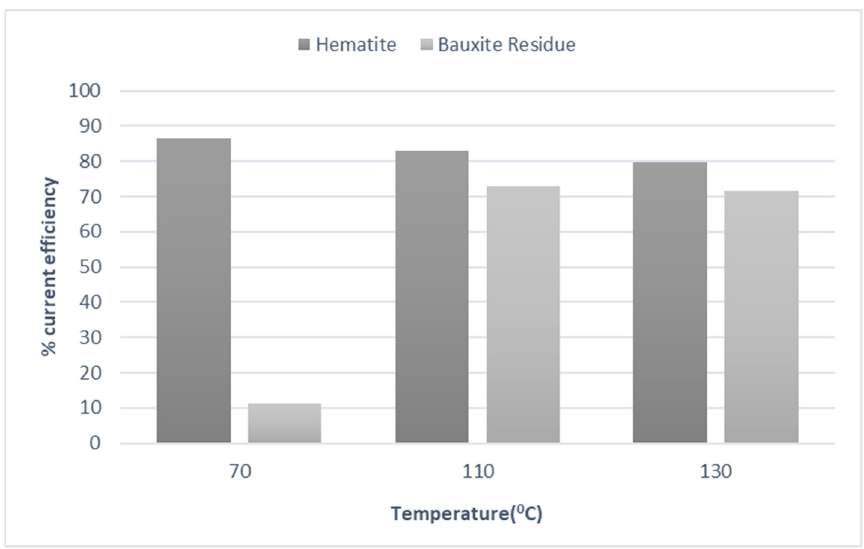
Figure 4. Current efficiency as a function of temperature for hematite and bauxite residue.